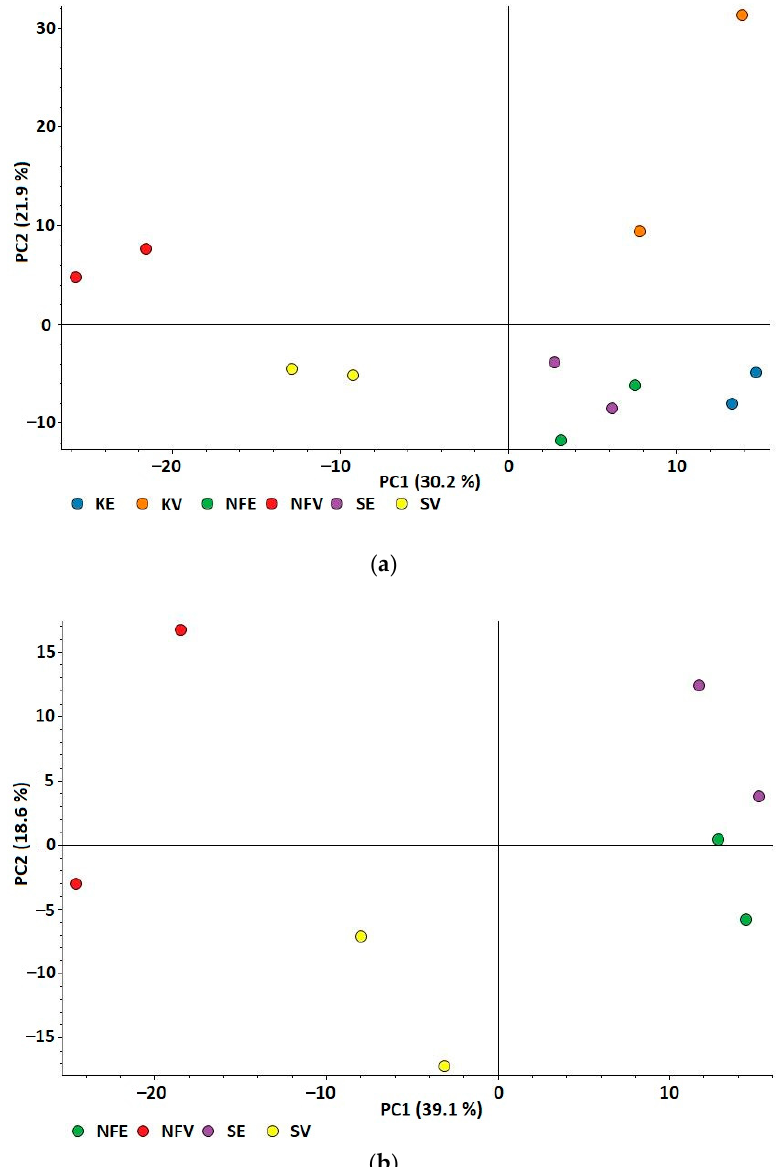
Figure 1. Principal Component Analysis (PCA) of protein abundances. Projection of four sets of samples: yeast treated with fermented Spirulina water extract (SV), non-fermented Spirulina water extract (NFV), fermented Spirulina ethanol extract (SE), and non-fermented Spirulina ethanol extract (NFE); and two sets of control samples: water control sample (KV) and ethanol control sample (KE). ( a ) PCA of all samples; ( b ) PCA of samples without control samples.